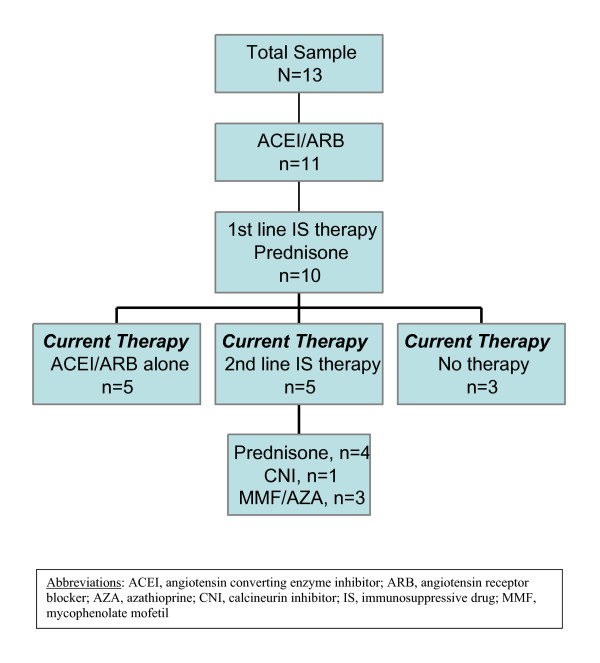
Summary of treatment provided to the patients with IMN.